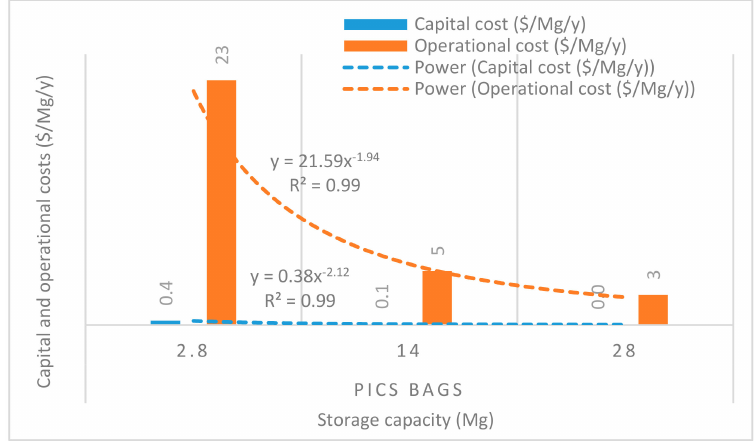
Figure 9. Economies of scale of capital and operational costs ($ / Mg / y) of using metal silo and all accessories.